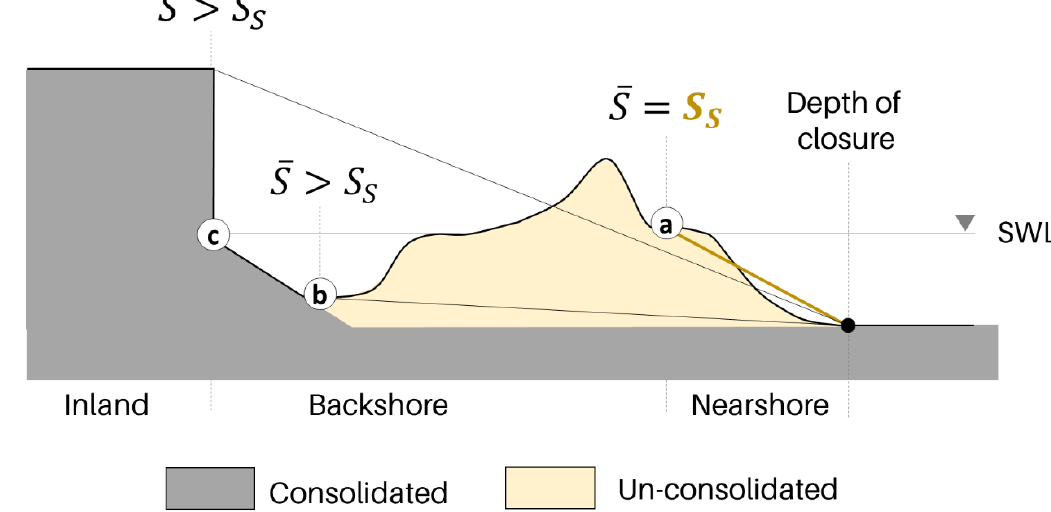
Figure 1. Applications of the essential Bruun rule to different control volumes produce different instantiations. ( a ) Application to a shoreface and beach gives the classic Bruun rule. ( b ) Application to a beach and shoreface backed by a barrier island gives a barrier Bruun rule. ( c ) Application to a beach and shoreface backed by a cliff gives a cliff Bruun rule. In each case, the implied transgression slope (black dashed line) equals the average profile slope 𝑆̅ , but only in the classic Bruun rule is this equal to the nearshore slope S s (gold solid line). (Adapted by authors from [7] .)